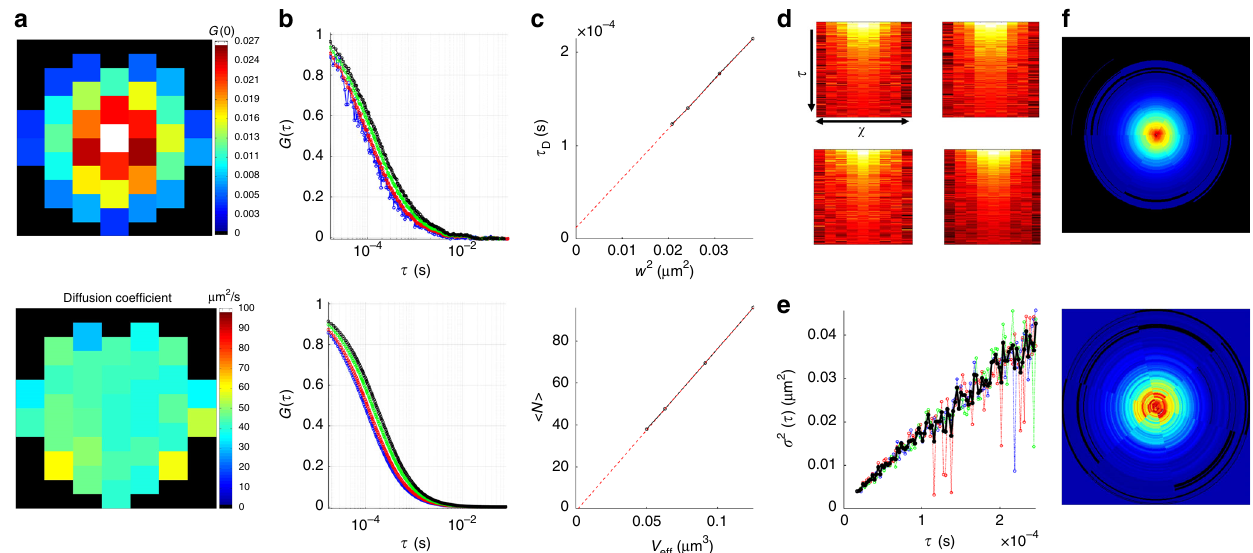
Fig. 3 a Map of the fi tted G (0) for the single detectors (top) together with intensity distribution (bottom). b FCS curves computed from a typical measure in the cytoplasm (top) together with the fi tting with a single component diffusion model (bottom), the colors refer to rings the volumes used for the spot- variation FCS (volume increasing going from blue, red, green and black, respectively, as shown in Fig. 1a), the curves are normalized to the fi tted G(0) values, c spot-variation curves obtained from the fi tting of b, fi tted diffusion time as a function of the waist squared (top) and average number as a function of the effective volume (bottom). d G ð χ ; τ Þ carpets for directions 1 (top left), 2 (top right) and 3 (bottom left) together with the average of all three directions (bottom right). e iMSD curve relative to directions 1 – 3 (blue, red, and green curves, respectively) and average (black curve). f 2D-pCF function for distance 1 (top) and 4